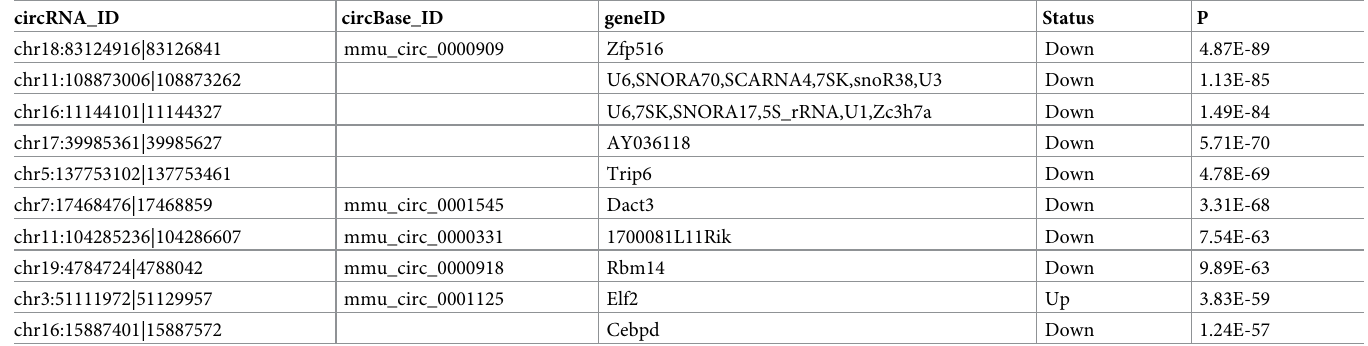
Table 2. Top 10 dysregulated circRNAs in MLO-Y4 cells treated with N.g MDP.